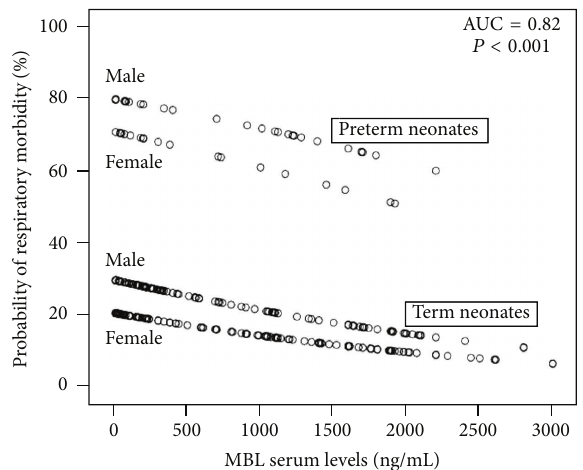
Figure 3: Multivariate logistic regression model indicated the prob- ability of respiratory morbidity according to the MBL serum levels, corrected for prematurity and